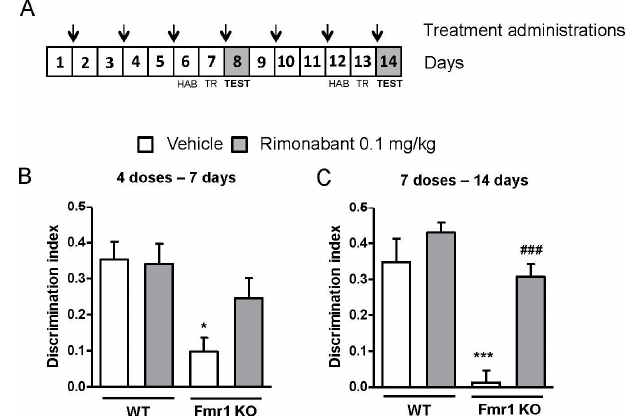
Figure 3. Discontinuous treatment with a low dose of rimonabant normalizes the cognitive impairment observed in the Fmr1 KO mice. ( A ) Mice were treated with a low dose (0.1 mg/kg) of rimonabant or its vehicle every two days during 14 days. Mice were exposed to the novel object recognition test after ( B ) 4 administrations (7 days) (WT-Veh, n = 4; WT-Rim, n = 6; Fmr1KO-Veh, n = 3; Fmr1KO-Rim, n = 5) and ( C ) after 7 administrations (14 days) (WT-Veh, n = 4; WT-Rim, n = 6; Fmr1KO-Veh, n = 3; Fmr1KO-Rim, n = 5) of vehicle or rimonabant. On day 7 and 14, drugs were administered after the training phase and discrimination indexes were obtained 24 h after training. Abbreviations: Veh, vehicle; Rim, rimonabant; HAB, habituation; TR, training. Data are expressed as mean ± SEM. * p < 0.05 and *** p < 0.001 (Fmr1 KO vs. WT mice); ### p < 0.001 (rimonabant vs. vehicle treatment).